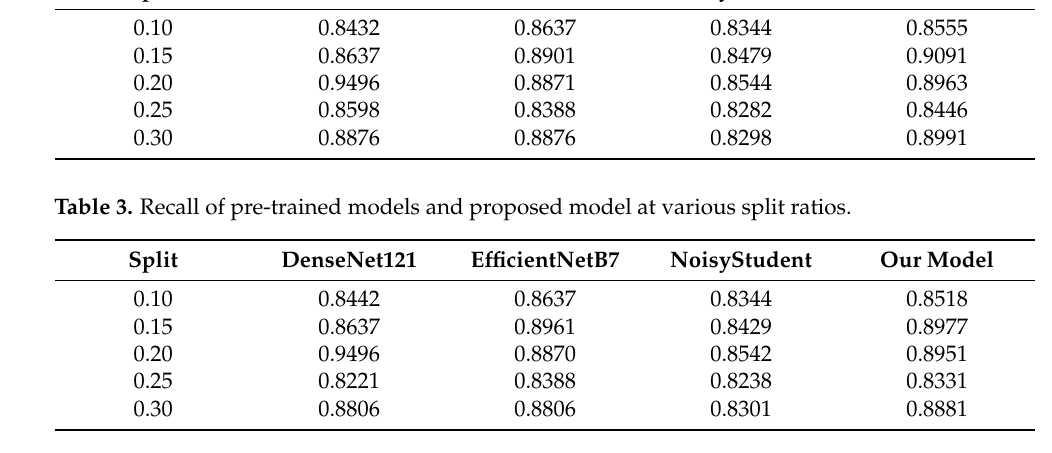
Table 2. Precision of pre-trained models and proposed model at various split ratios. Split